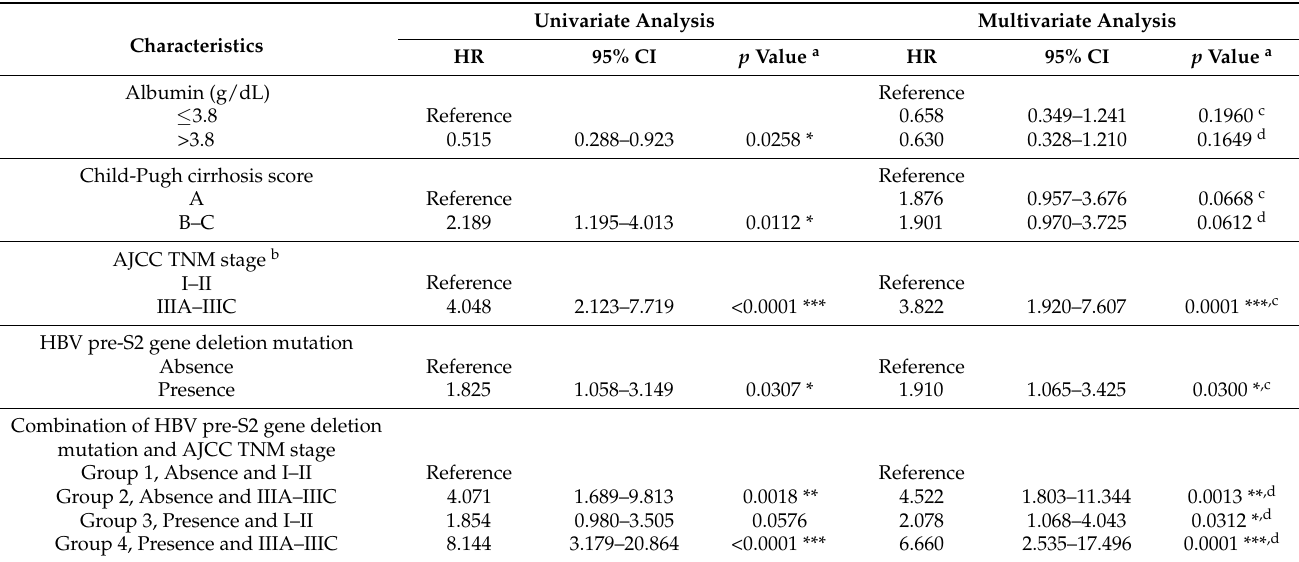
Table 4. Univariate and multivariate RFS analyses of HBV pre-S2 gene deletion mutation combined with AJCC TNM stage in 75 HBV-related HCC